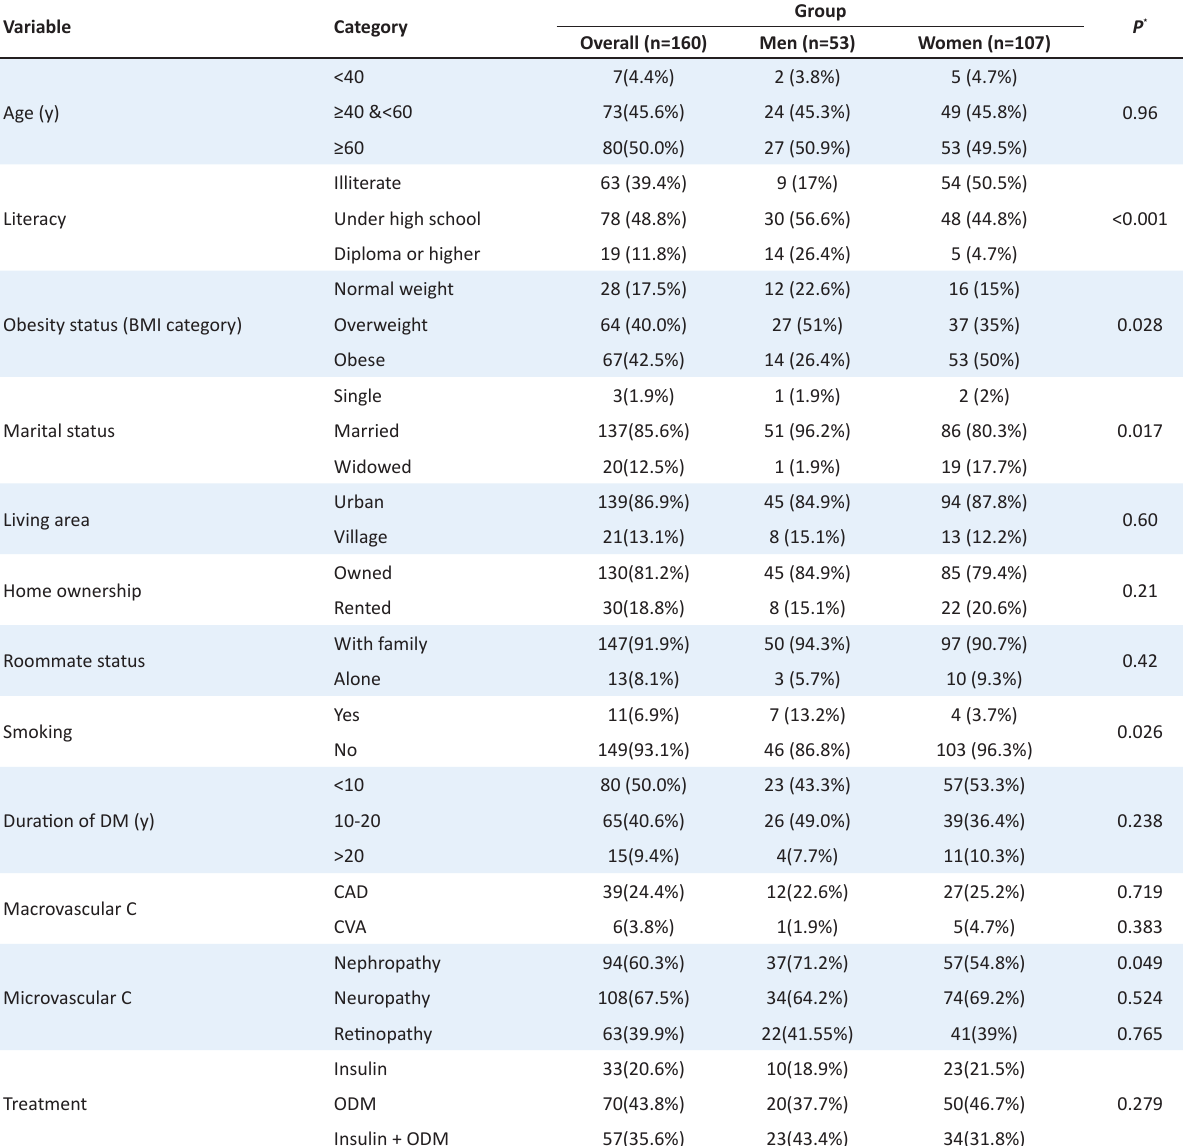
Table 1. Baseline demographic and clinical characteristics of patients with T2DM according to the gender Variable